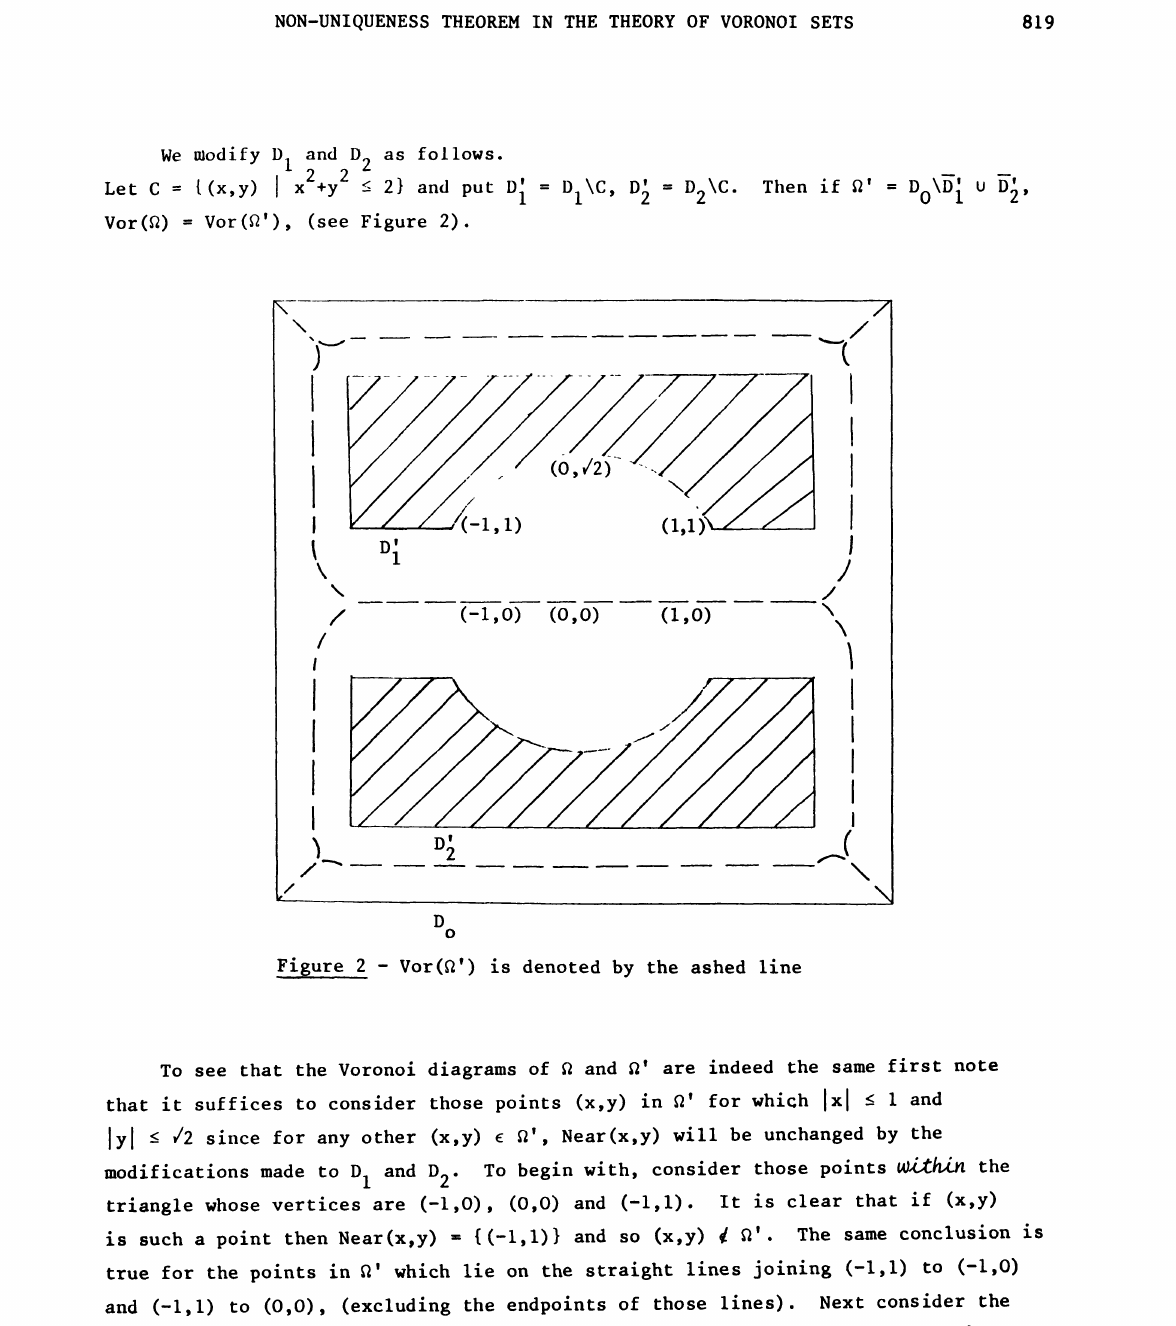
Figure 2 Vor(’) is denoted by the ashed